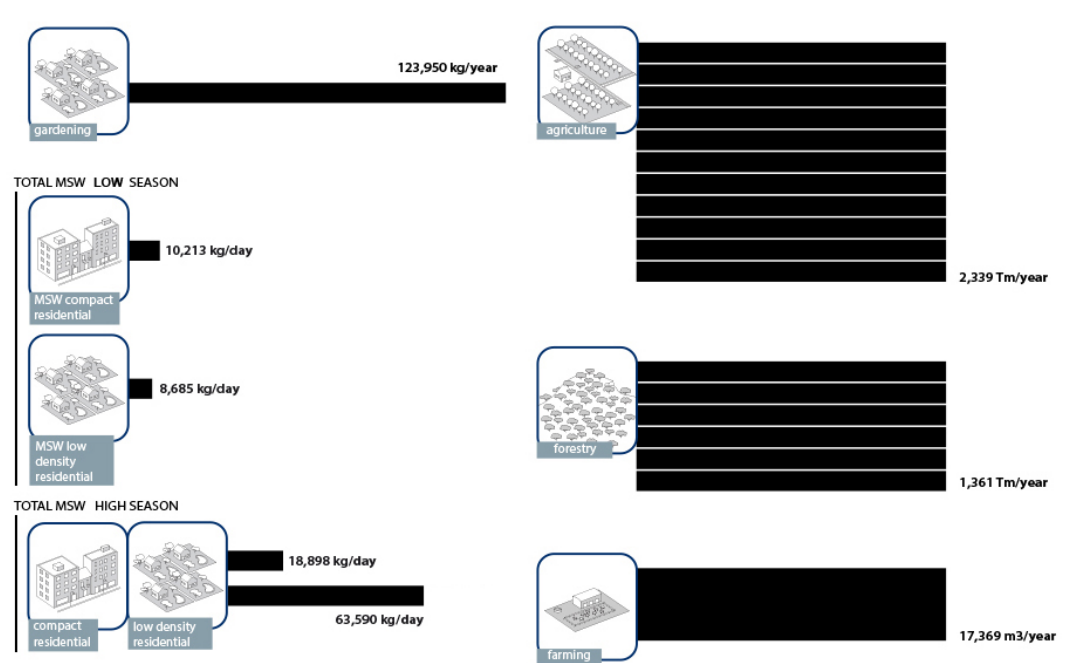
Figure 5. Main waste or residues flows in the SCSP. Source: Galan (2014b).